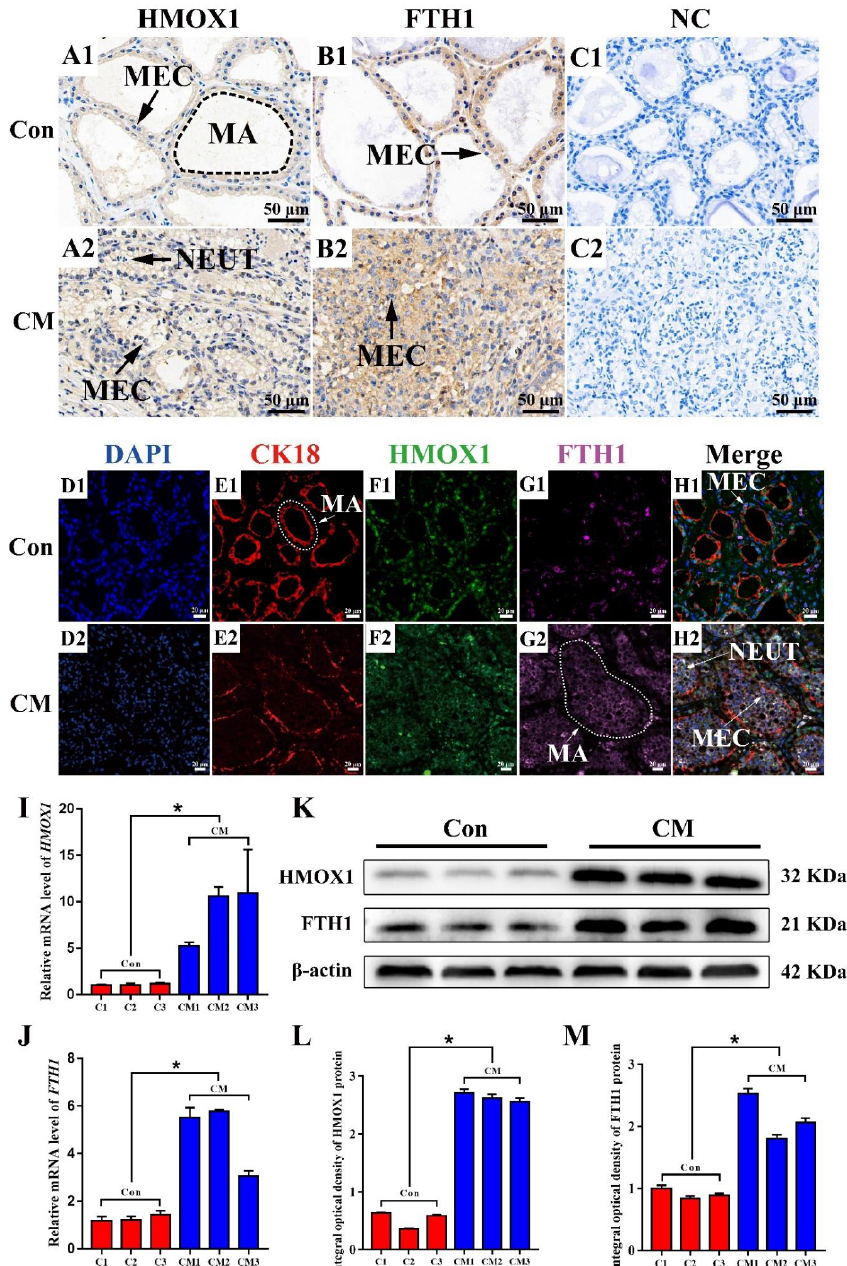
Figure 4. The distribution and expression pattern analysis of HMOX1 and FTH1 in the mammary glands of the Holstein cows. ( A , B ) The distribution analysis of HMOX1 ( A1 , A2 ) and FTH1 ( B1 , B2 ) in the mammary glands of the Con and CM groups using IHC staining. ( C ) Negative control HMOX1 and FTH1 in the mammary glands of the Con and CM groups. ( D – H ) Co-location analysis of DAPI ( D ), CK18 ( E ), HMOX1 ( F ), FTH1 ( G ) and the merged images in the mammary glands of the Con and CM groups using IF staining. ( I , J ) The expression pattern analysis of HMOX1 ( I ) and FTH1 ( J ) mRNA in mammary glands of the Con and CM groups using qRT-PCR. ( K ) Western blot expression pattern analysis of HMOX1 and FTH1 proteins in the mammary glands of the Con and CM groups. ( L , M ) The IOD values of HMOX1 ( L ) and FTH1 ( M ) proteins in the mammary glands of the Con and CM groups. MA, mammary alveoli. MECs, mammary epithelial cells. NEUT, neutrophil. IOD, integral optical density. Scale bar of 50 µ m, and 20 µ m represents 400 × and 630 × , respectively. Con/C, control. CM, clinical mastitis. NC, negative control. Statistical analyses: Wilcoxon rank sum test, α = 0.05. Data are presented as median (rank). * represents p <